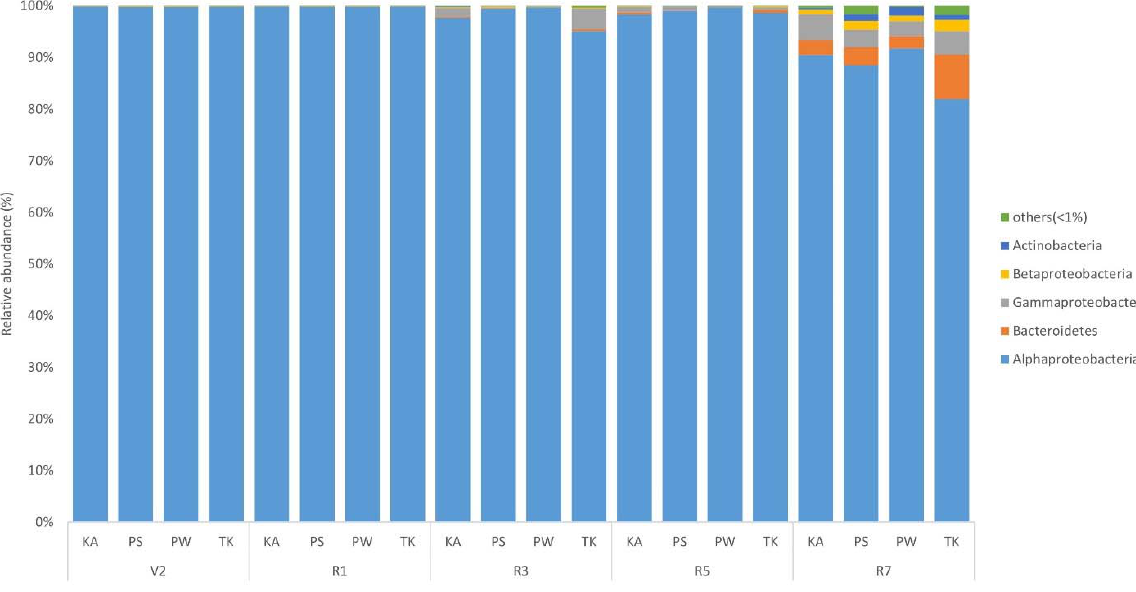
Figure 4. Relative abundance of major phyla presents in root nodule based on the variety and growth stages (V2, R1, R3, R5, R7) of soybean. KA, Kwangan; PS, Poongsannamul; PW, Poongwon; TK, Taekwang. Each bar represents the average relative abundance of triplicates.